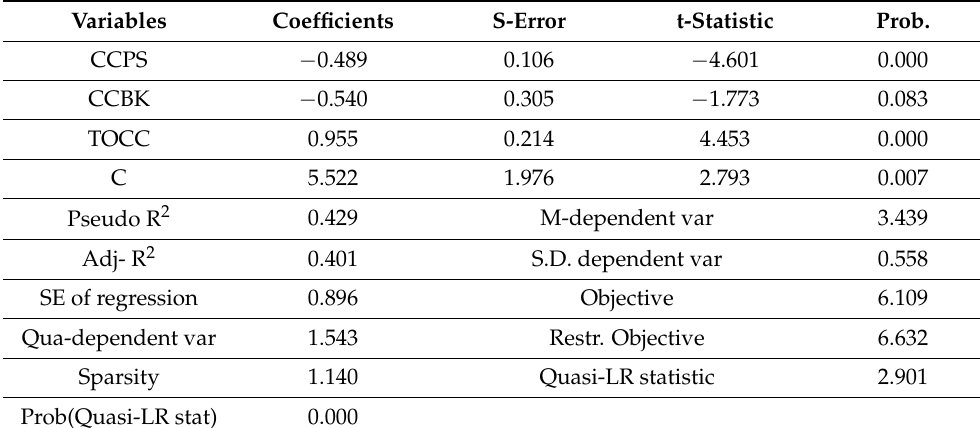
Table 4. Fiftieth (0.50) quantile regression estimates of Equation